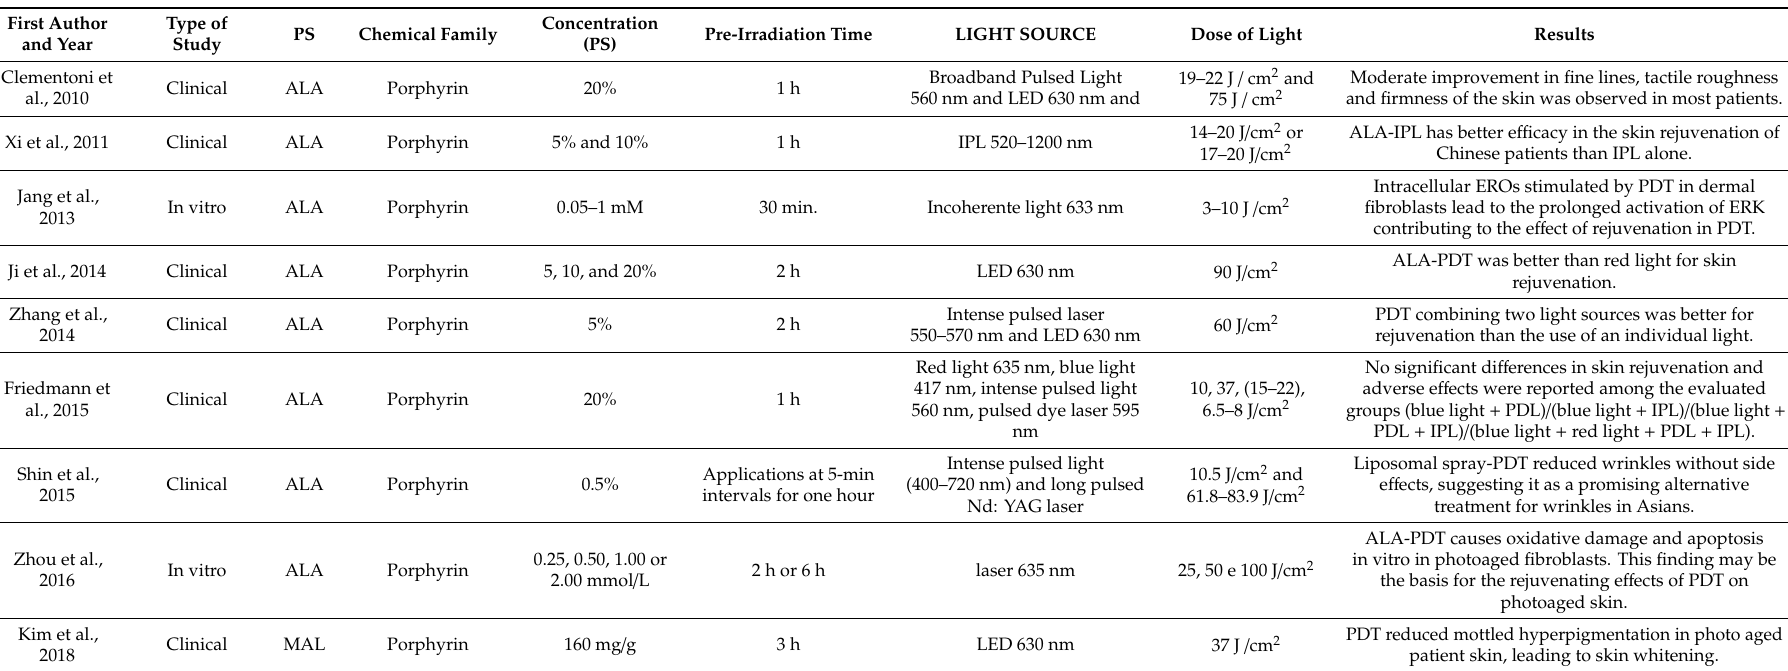
Table 6. Description of the studies using porphyrin derivatives in skin